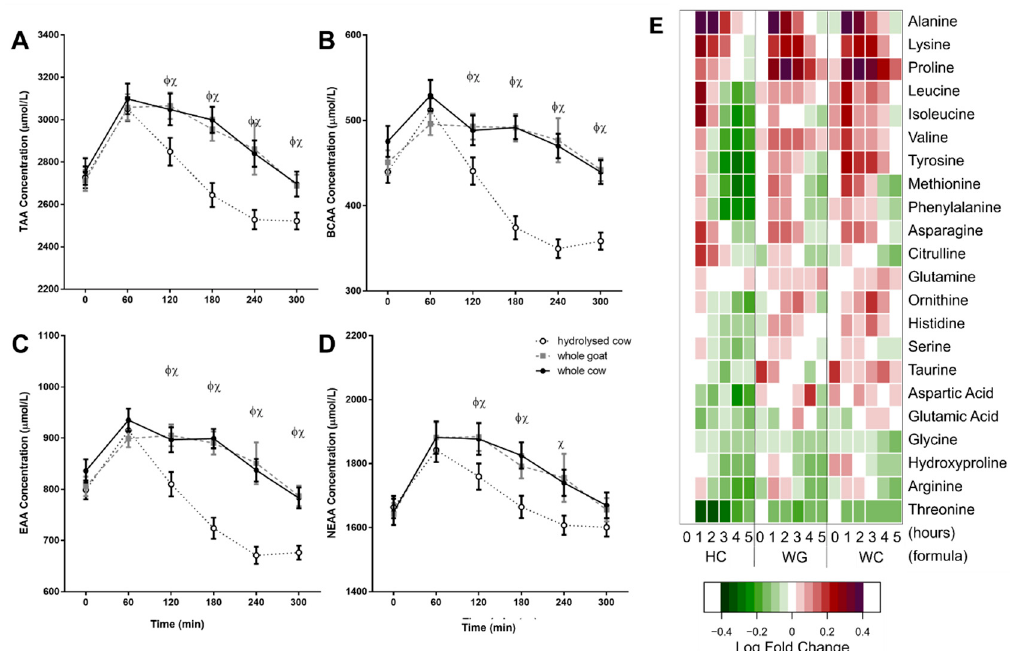
Figure 2. Plasma amino acid responses following formula ingestion. ( A ) Total amino acids (TAA). ( B ) BCAA. ( C ) Essential amino acids (EAA). ( D ) Non-essential amino acids (NEAA), ( E ) Individual amino